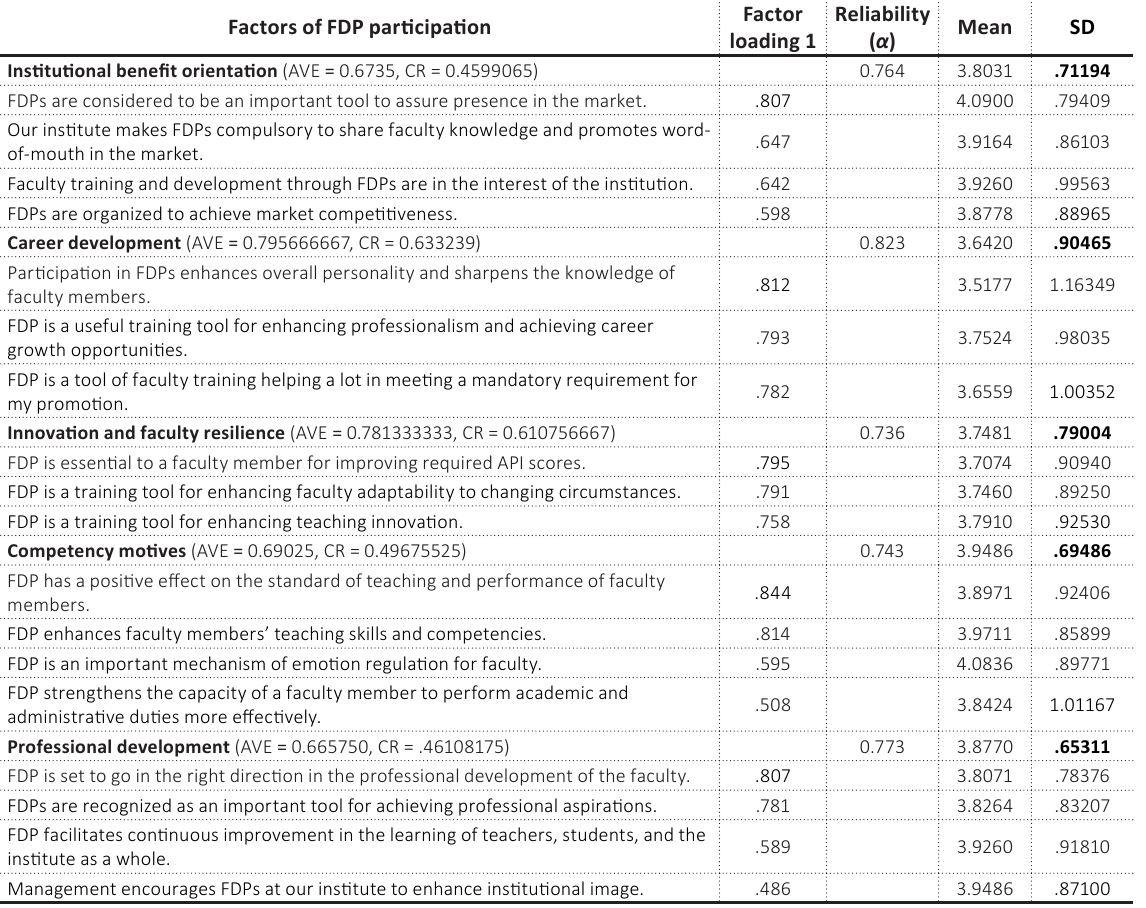
Table 3. Analysis of FDP